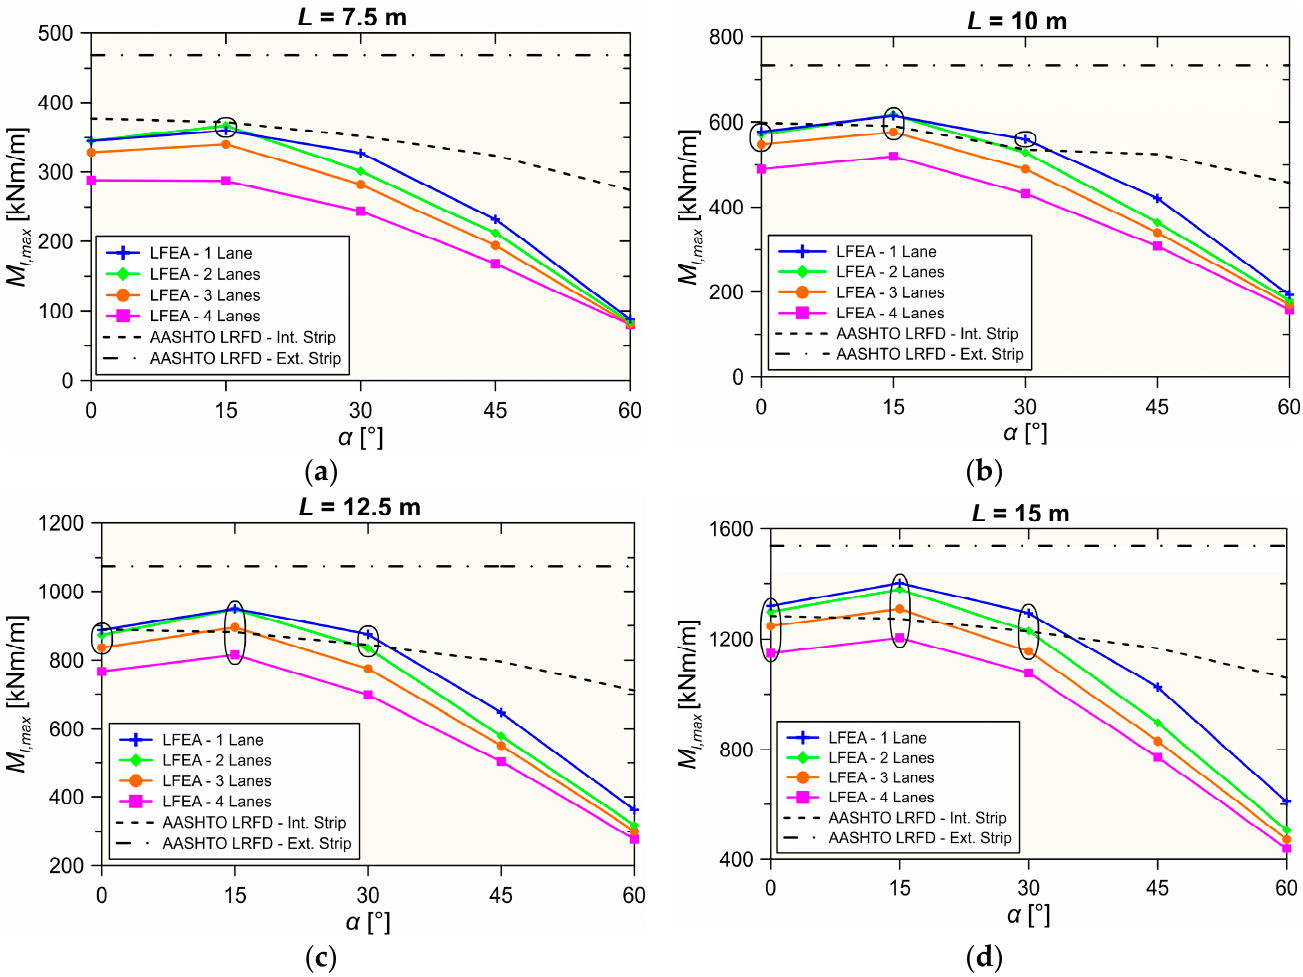
Figure 7. Comparison of LFEA and AASHTO LRFD maximum longitudinal bending moment. ( a ) L = 7.5 m, ( b ) L = 10 m, ( c ) L = 12.5 m, ( d ) L = 15 m. Circled data indicates that the same reinforcement was provided with LFEA and AASHTO